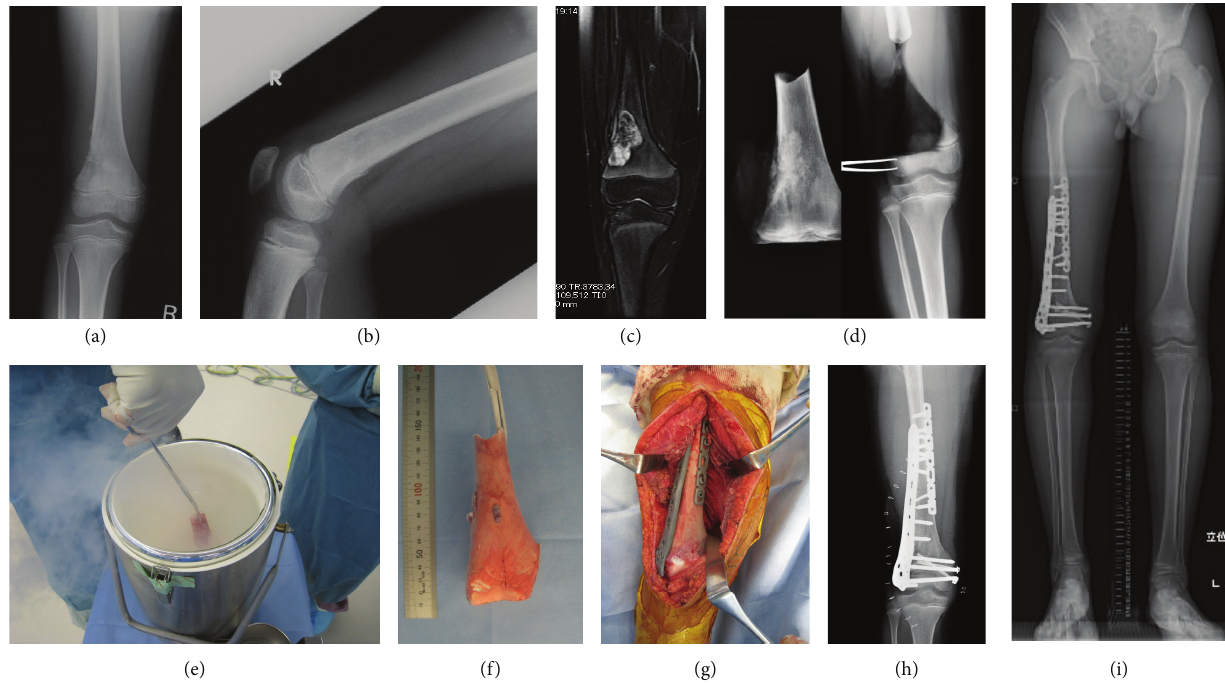
Figure 3: Case presentation representing a ten-year-old boy at time of surgery with osteosarcoma distal right femur. (a, b) Anteroposterior and lateral view of distal femur XR showing the tumor mass. (c) T2 weighed MRI image of the distal femur showing the tumor mass with high signal intensity. (d) Intraoperative XR showing the freely resected segment to be frozen and the host bone. (e) Intraoperative photo of free freezing. (f) The tumor bearing bone after freezing. (g) The frozen segment after repositioning and fixation. (h) Postoperative XR of the distal femur after freezing and fixation. (i) Long length film showing a LLD of